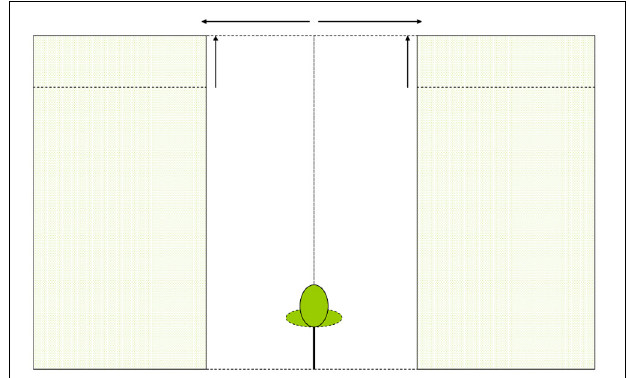
FIGURE 1 | Schematic presentation of a tree and its surrounding vegetation in the PHOLIAGE-model. Characteristics of both tree and vegetation can be